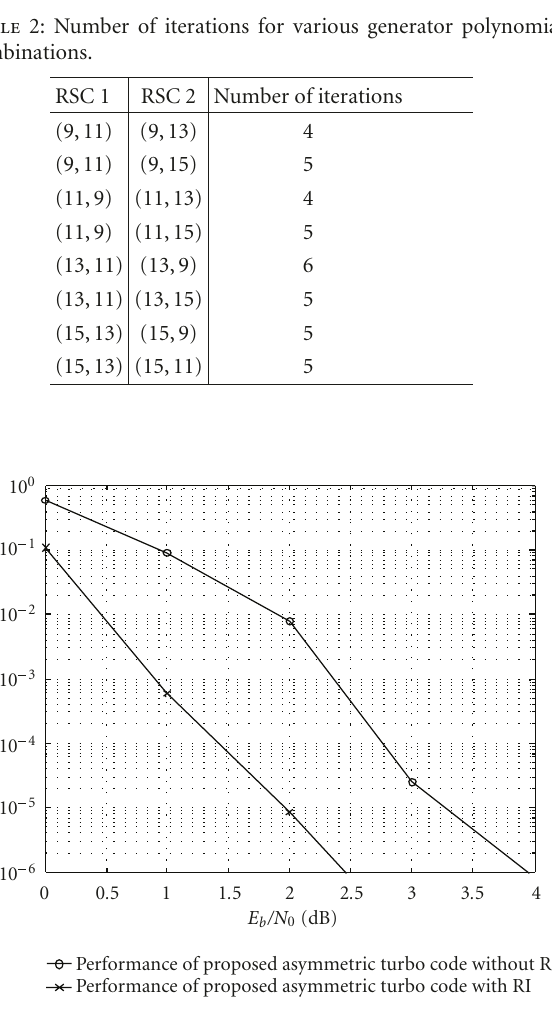
Figure 7: Simulation results for proposed asymmetric turbo code with and without random interleaver (RI).